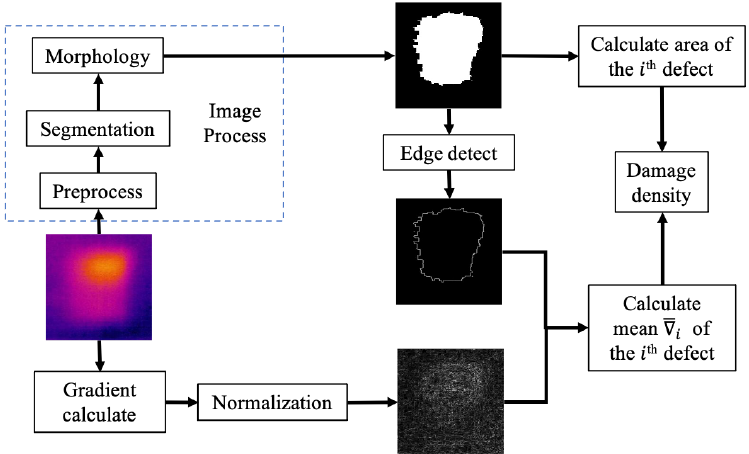
Figure 1. The diagram of the proposed